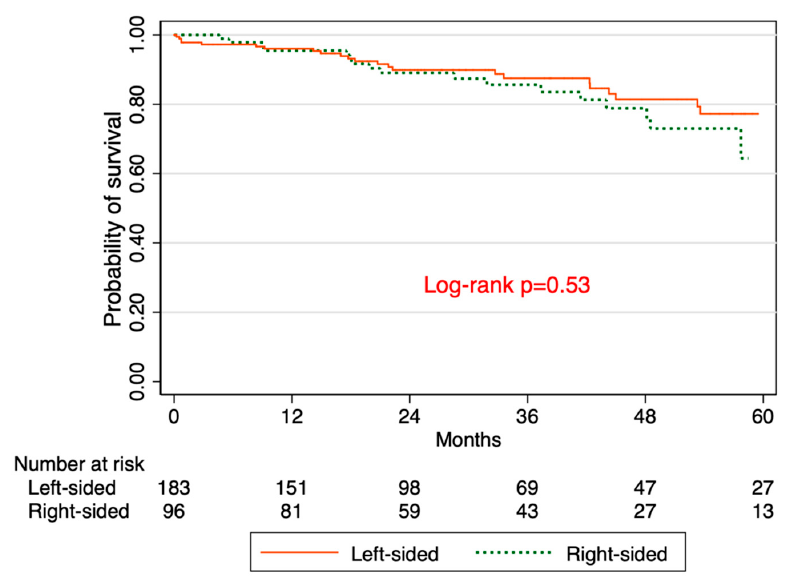
Figure 2. Kaplan–Meier survival based on tumor location.